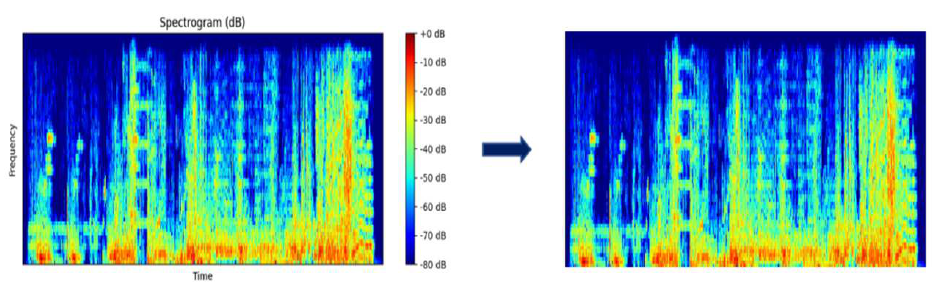
Figure 3. STFT spectrogram data preprocessing.